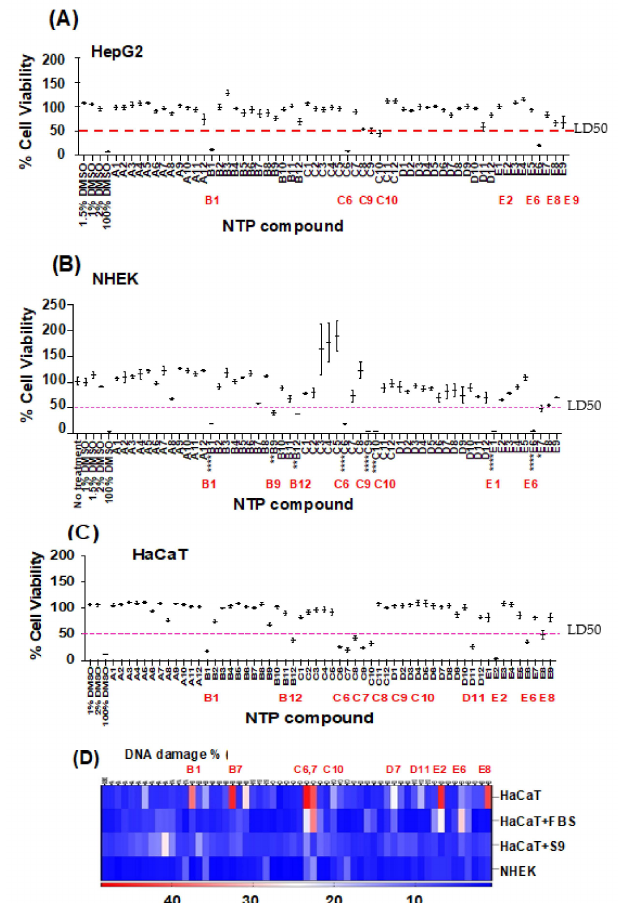
Figure 5. XTT cell viability assays of HepG2 ( A ) primary NHEK ( B ) and HaCaT keratinocytes ( C ) after treatment with 57 NTP compounds. HepG2 cells ( A ), primary NHEK keratinocytes ( B ), and HaCaT cells ( C ) were exposed to each of the 57 NTP compounds (designated A1–E10 ( x -axis)) at 200 µ M for 3 h and subjected to CometChip assay. ( D ) DNA damage (% tail DNA tail; n = 2) after exposure of HaCaT or NHEK cells with or without FBS or S9 activation. Error bars represent mean +/ − SEM; one-way ANOVA in comparison to 1% DMSO control; *, **, *** and **** represent p < 0.05, p < 0.01, p < 0.001 and p < 0.0001,